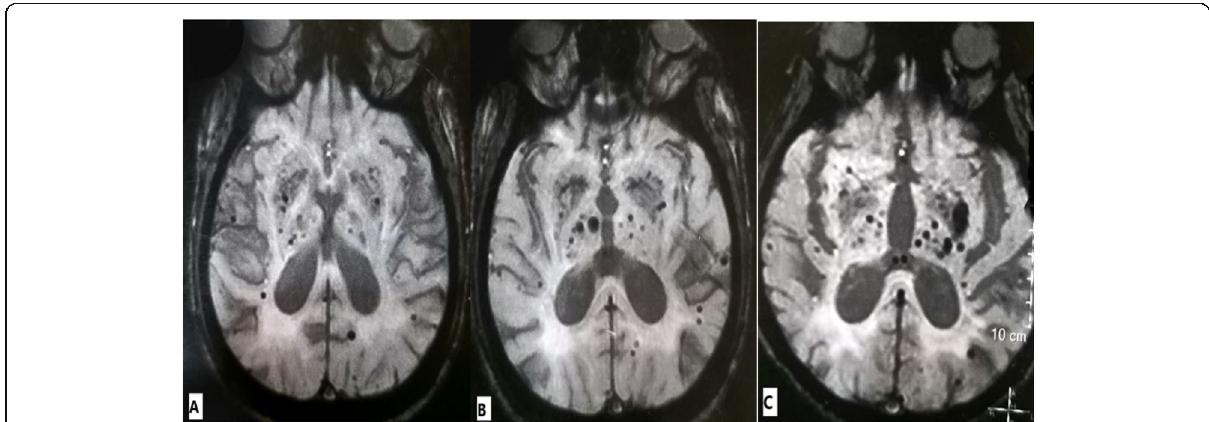
Fig. 3 Mixed type cerebral microbleeds. Axial brain SWI images ( a – c ) show bilateral multiple signal loss areas of cerebral microbleeds in the, basal ganglia, both thalami, deep periventricular and subcortical white matter, and cortical